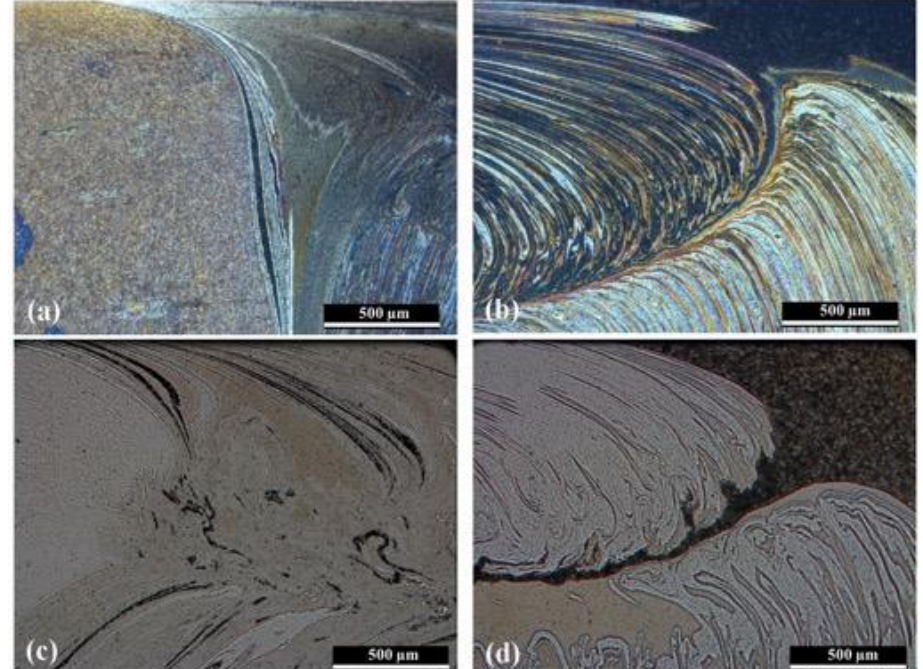
Figure 6. Comparison of material flow between the advancing and retreating sides of 562 welds series: ( a ) Advancing Side-562-30, ( b ) Retreating Side-562-30, ( c ) Advancing Side-562-120, and ( d ) Retreating Side-562-120.